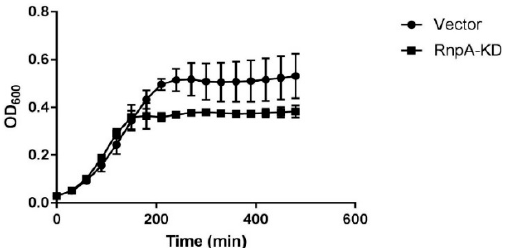
Figure 5. Hypersusceptibility growth curve of S. aureus RN4220 pML100 vector ( ● ) and RN4220 pML100:: rnpA-KD ( ■ ) treated with 0.25× MIC JC2 (0.125 µg·mL − 1 ). Curves are averages of two biological replicates with technical duplicates.